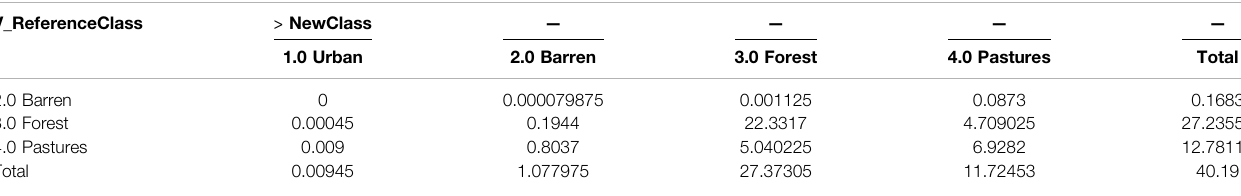
TABLE 5 | Land Cover change matrix (km 2 ) for the whole